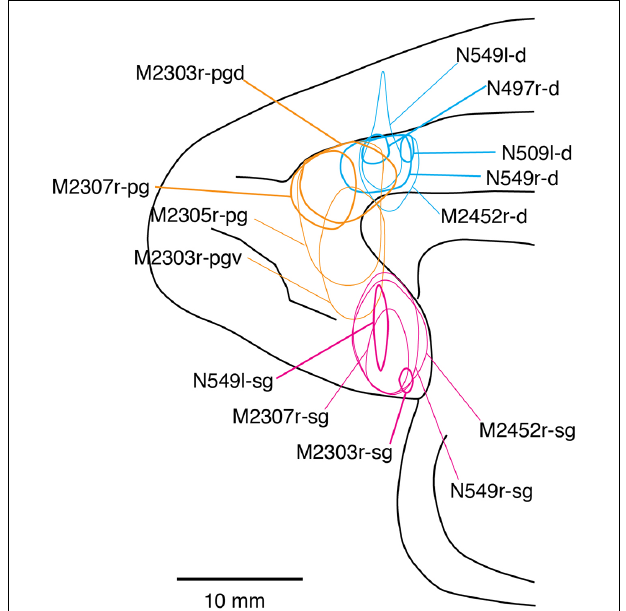
FIGURE 3 | Tracer injection sites shown from the medial view of the brain. Actual injections were in either the left or right hemispheres. The sgACC, pgACC, and dACC injection sites are delineated in magenta, orange, and cyan, respectively. Thick lines indicate the injections that were confined to the targeted area, whereas the thin lines indicate the injections that spread to the neighboring structures (i.e., the striatum).